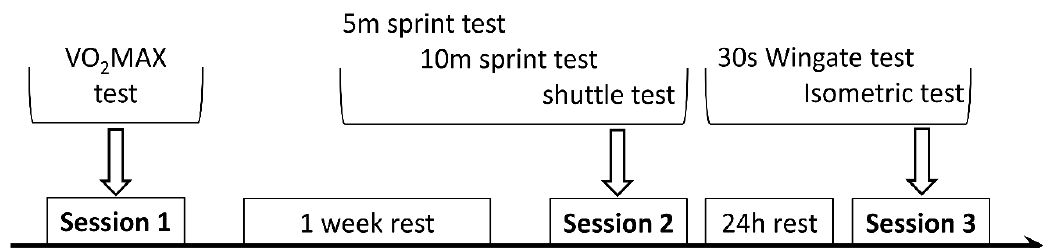
Figure 2. Schematic representation of the experimental protocol.